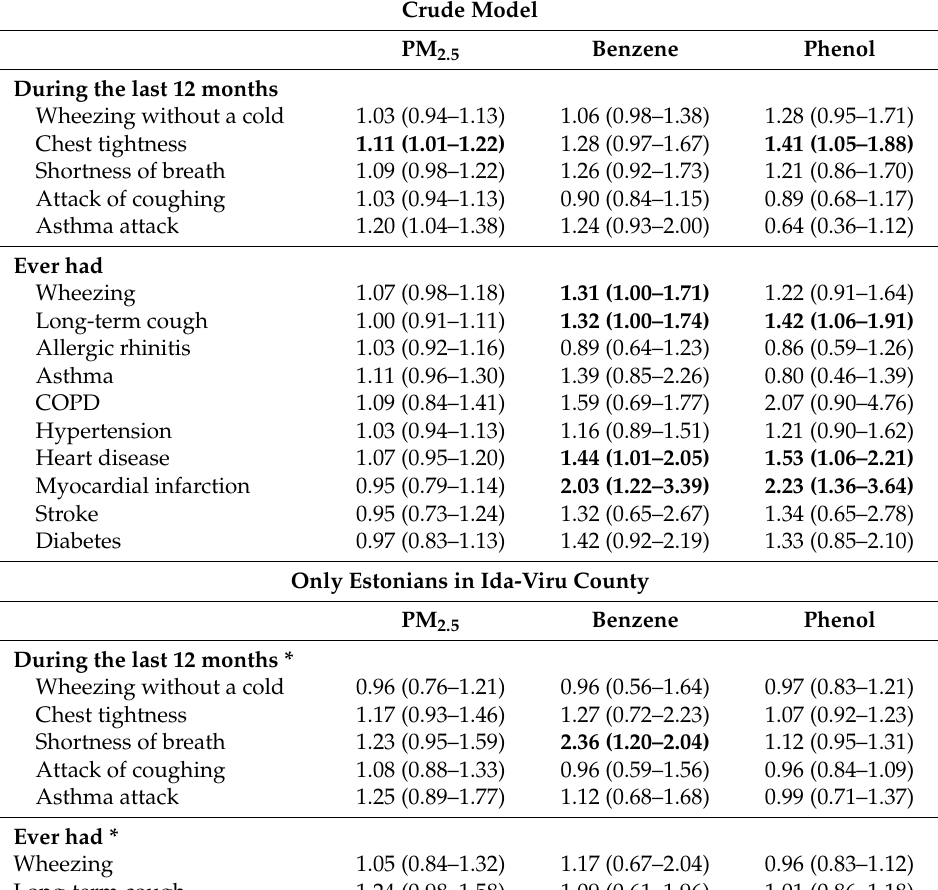
Table A1. Odds ratios (95% CI) on disease prevalence per interquartile change in pollutants concentrations.